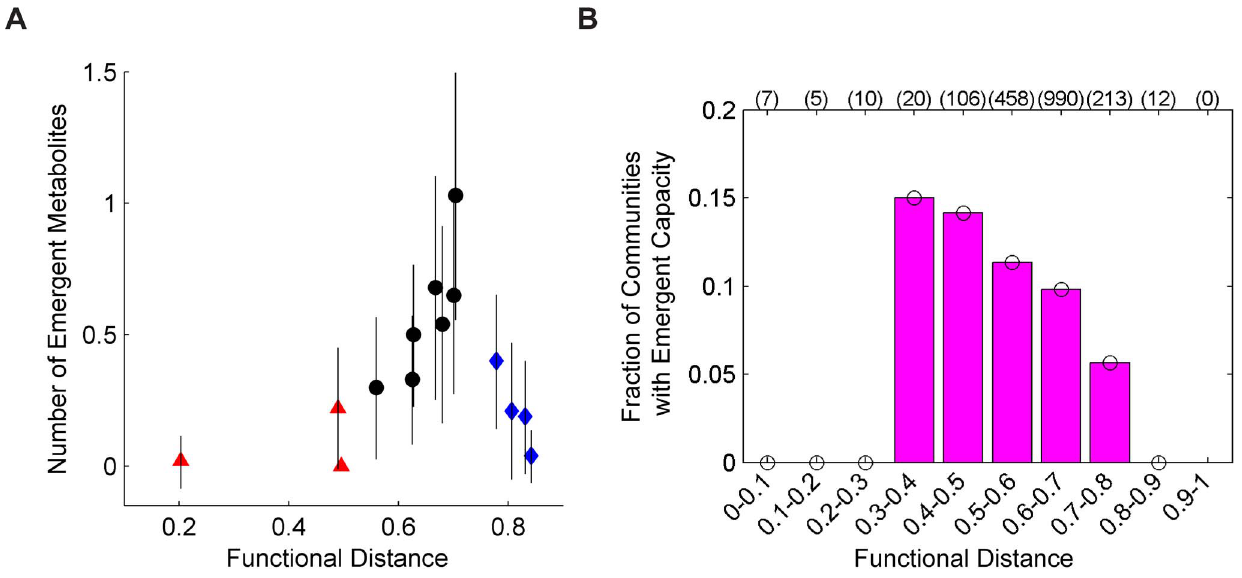
Figure 7. The Goldilocks principle of emergent biosynthetic capacity observed in simple two-species communities. ( A ) The average number of emergent metabolites (and standard error) across 100 media in each of the communities containing 2 of the 6 species in our first dataset vs. the functional distance between the two species. Red triangles denote pair-wise combinations of the three proteobacteria E. coli , S. typhimurium , and S. oneidensis . Blue diamonds denote communities composed of a bacterium paired with the archaeon M. barkeri . The pair M. barkeri / S. oneidensis was not included in this analysis since no neutral media for this pair was found in [48]. Functional distances were calculated as the Jaccard distance between the set of KEGG orthology groups [101] present in the two species (Methods). ( B ) The fraction of communities that exhibit emergent biosynthetic capacity across communities containing 2 of the 116 species in our second dataset within a given range of functional distances (Methods). Only the 1821 communities in which both species were still growing at the 1 hr time points are included, with the number of such communities in each bin shown in parentheses.